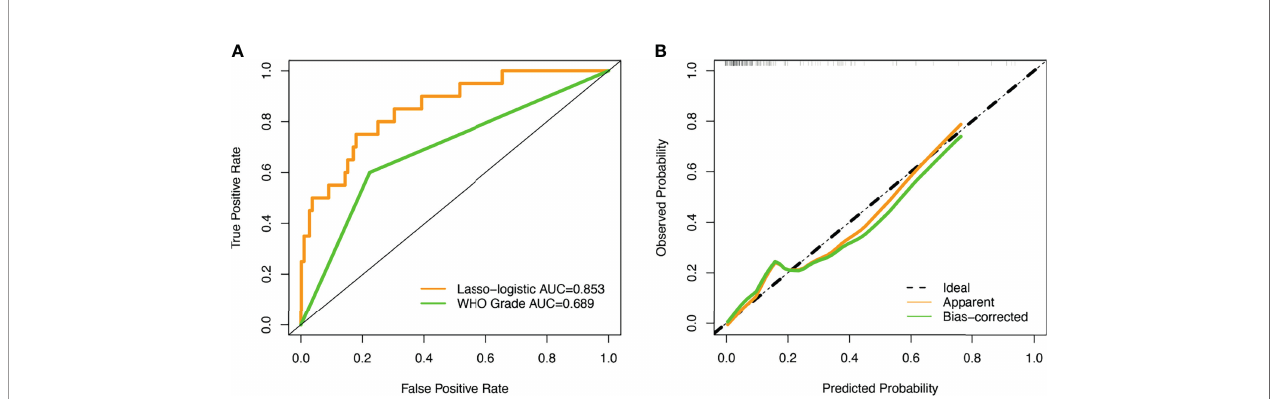
FIGURE 4 | ROC curve and calibration curve. (A) The AUC values of the novel algorithm and WHO grade was 0.853 (yellow) and 0.689 (green), respectively; (B) The calibration curve demonstrated that consistency between the predicted risk of recurrence probability and the actual probability by the nomogram.